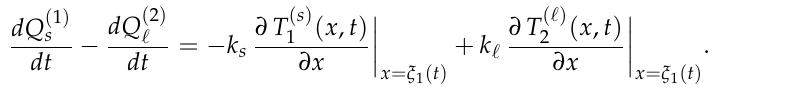
Figure 2. Three phase configuration with a PCM layer in the presence of two fronts. The two-front configuration is observed when the temperature on the exterior surface is below T m . The liquid layer releases thermal energy to the solid phases at regions 1 and 3 (supercooling effects are not